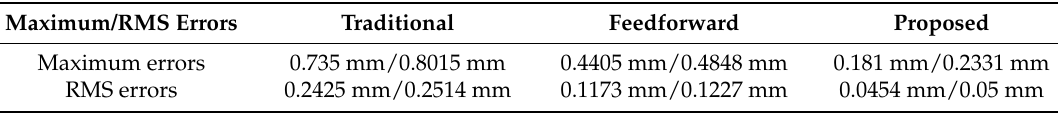
Table 6. Tracking errors under random